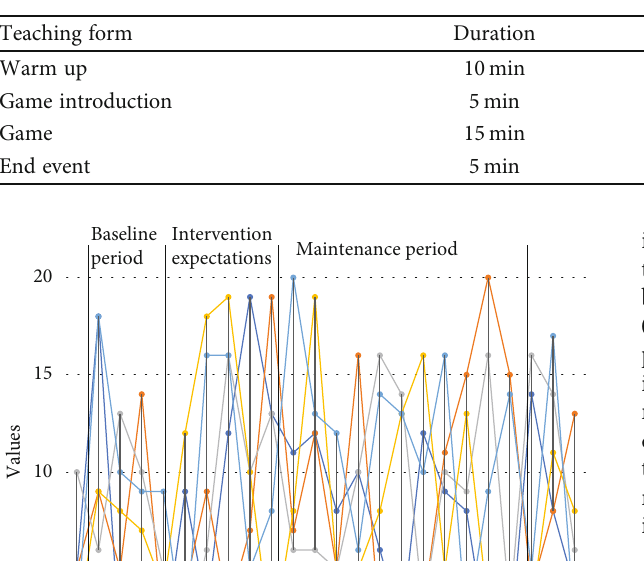
Table 1: Intervention period physical education game lesson fl ow.